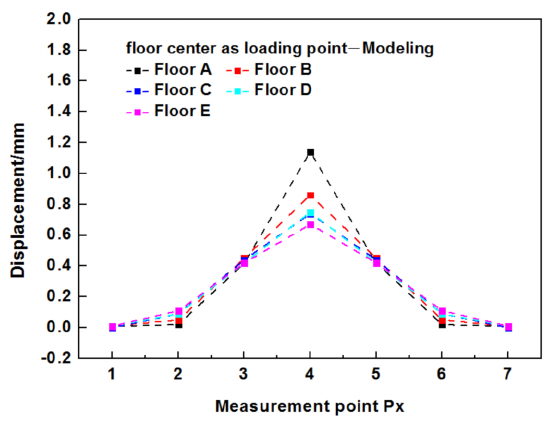
Figure 15. Predicted deflections at measurement point when floor center as loading